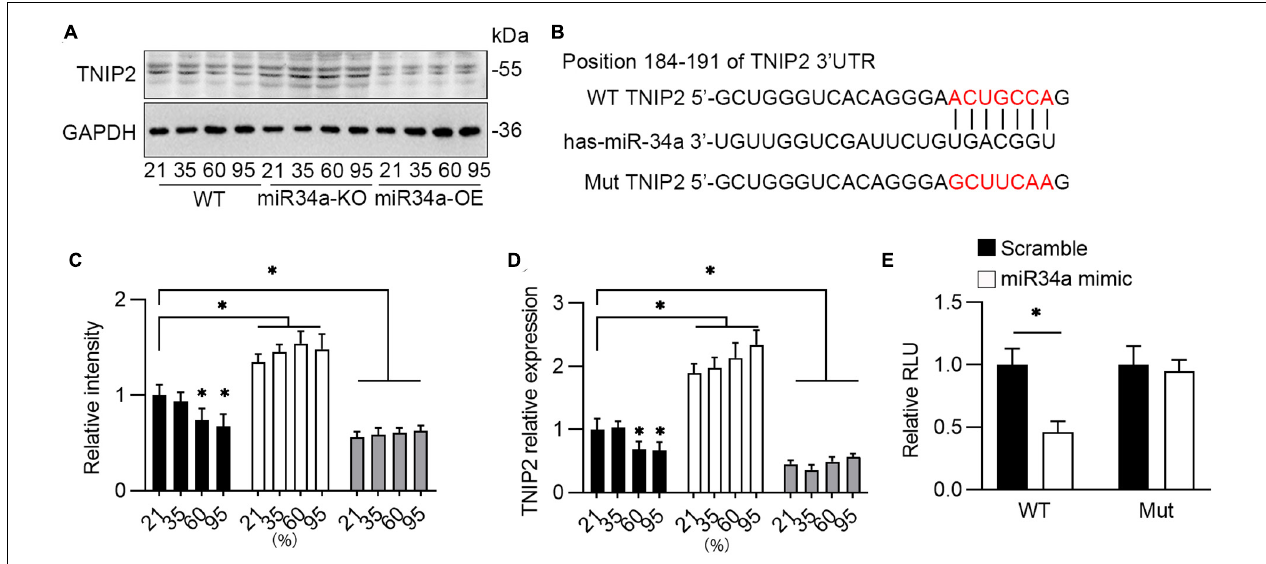
FIGURE 5 | Bioinformatics analysis miR34a’s downstream target. (A) WT, miR34a-KO, and miR34a-OE A549 cells was collected after to different concentration of oxygen for 72 h, then examined by TNIP2 antibody using Western blotting and (C) its statistical results, One-way ANOVA, ∗ p < 0.05 vs. 21%, n = 3. (B) Schematic diagram revealed bioinformatic prediction of miR-34a and 3’UTR of TNIP2 and mutated sequence. (D) qPCR analyzed mRNA of TNIP2 in WT, miR34a-KO, and miR34a-OE A549 cells after exposure to different concentration of oxygen for 72 h. One-way ANOVA, ∗ p < 0.05 vs. 21%, n = 3. (E) HEK293T were transfected with pGL3-3’UTR TNIP2 and miR34a mimic or scramble for 24 h and then analyzed using dual luciferase reporter gene. Unpaired t -test, ∗ p < 0.05 vs. scramble, n =